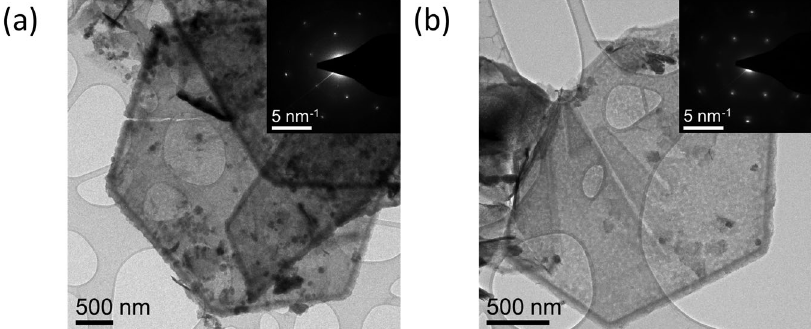
Fig. 9 Morphological and structural changes of the 10% MXene before and after OER. TEM images and corresponding SAED patterns for the 10% MXene after OER a Area 1 and b Area 2.